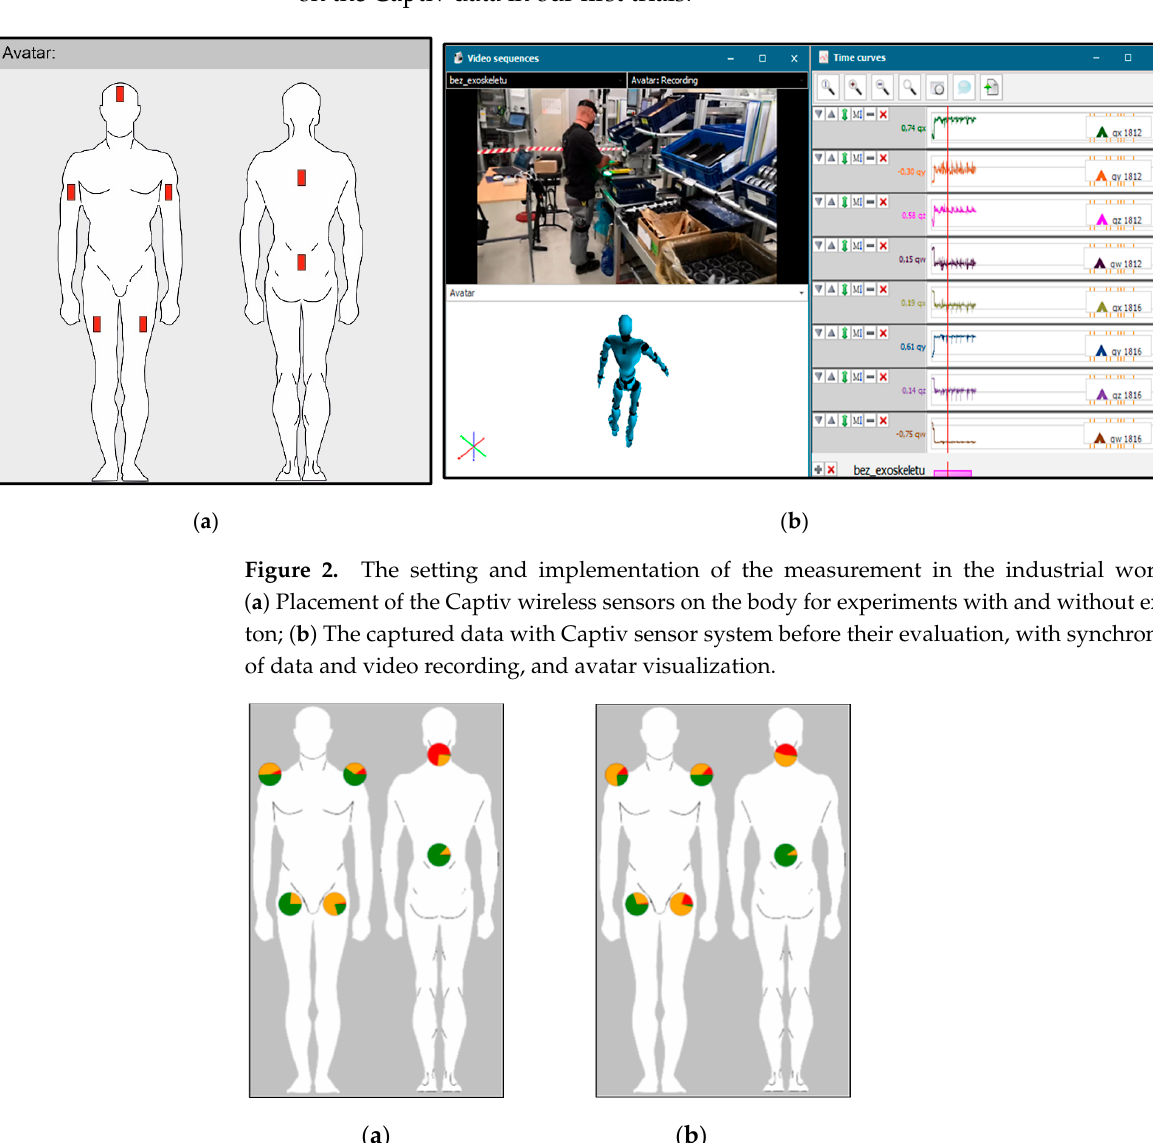
Figure 3. Postures. Evaluation as: ( a ) Postures evaluation results for work activity STAND (without exoskeleton); ( b ) Postures evaluation results for work activity measurement EXO (with exoskeleton).